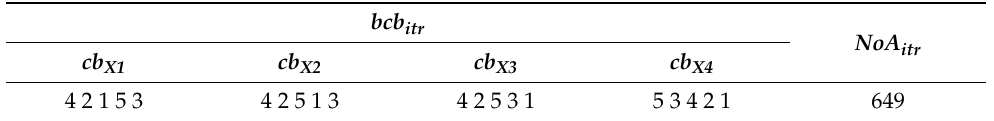
Table 8. Best combination of bins for the first iteration.